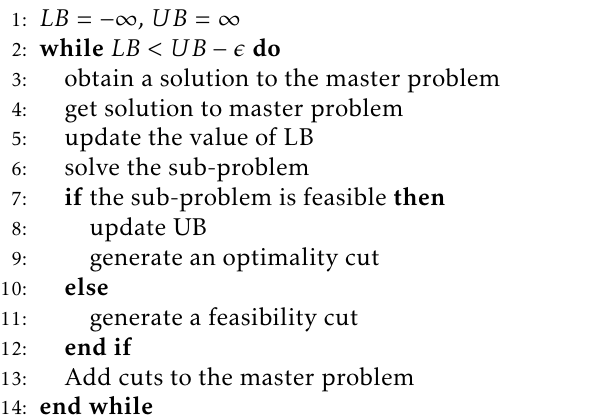
Algorithm 1 Benders decomposition